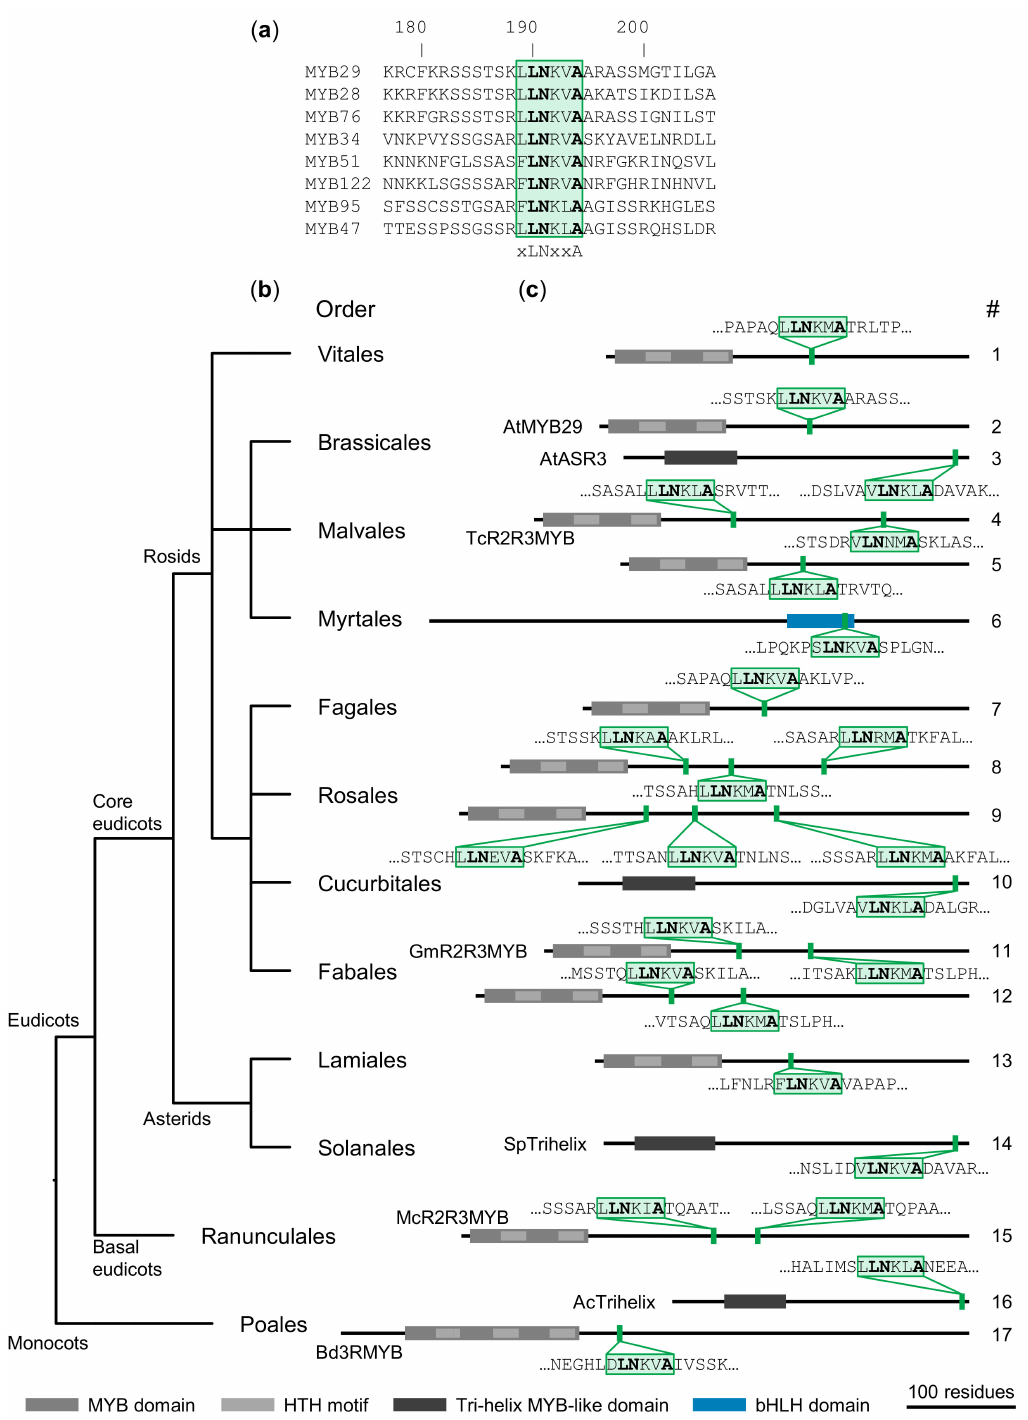
Figure 1. Examples of putative MYC-interaction motifs (MIMs) identified throughout the angiosperms. ( a ) Alignment of MIM-containing MYB transcription factors (TFs) from A. thaliana , with numbering according to AtMYB29, and with the MIM highlighted by a green box. ( b ) Phylogenetic tree showing the evolutionary relationship of orders with putative MIM-containing proteins. The tree was built with the NCBI Taxonomy Common Tree tool (https://www.ncbi.nlm.nih.gov/ taxonomy) and is not to scale. ( c ) Domain organization and localization of each individual protein with a putative MIM. Domain information was obtained from PROSITE [41]. The location of the putative motif is shown in green, and the core motif residues (xLNxxA) in bold. Numbers (#) refer to each putative MIM-containing protein in Table